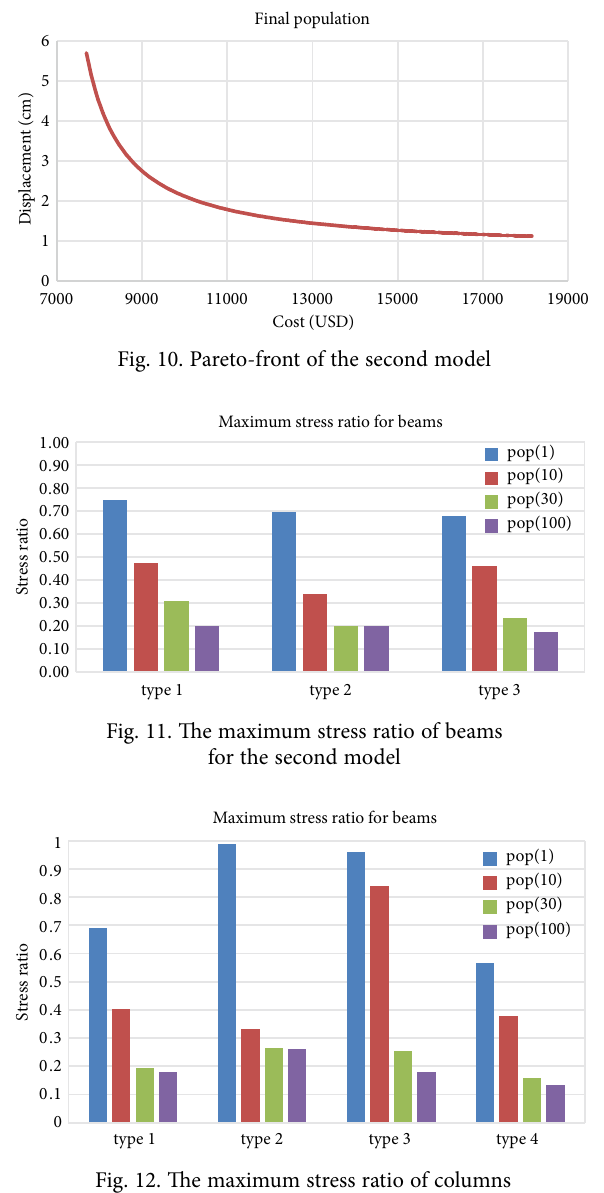
Fig. 12. The maximum stress ratio of columns for the second model